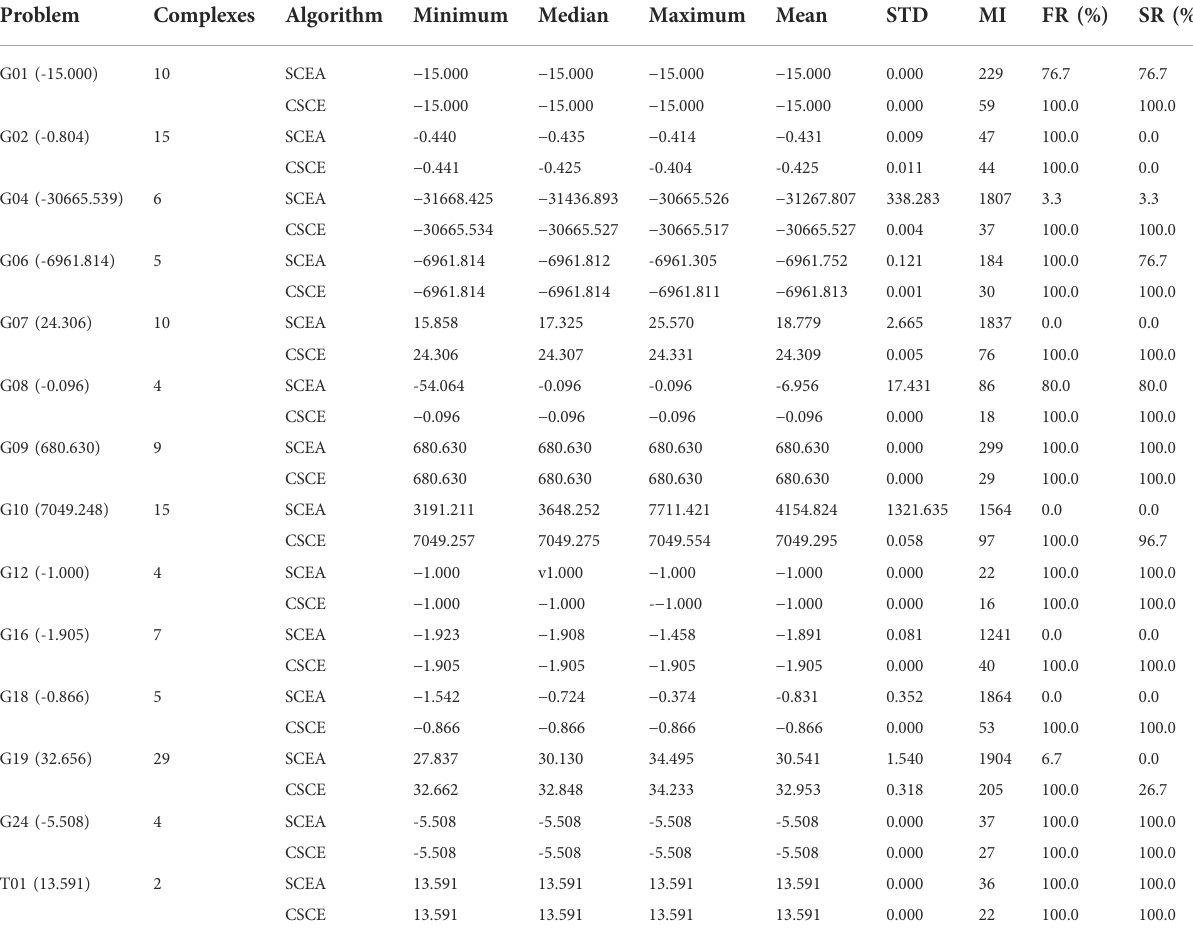
TABLE 3 Performance of the two algorithms on the test